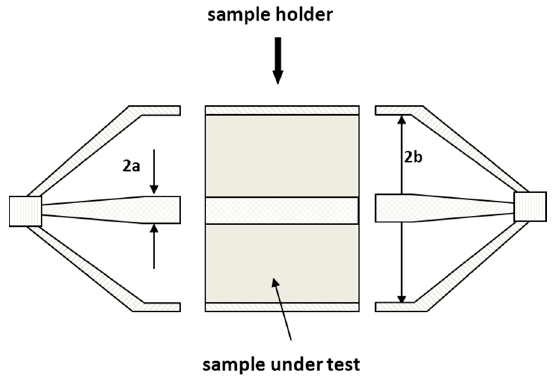
Figure 2. Scheme of the used coaxial cell for material analysis.